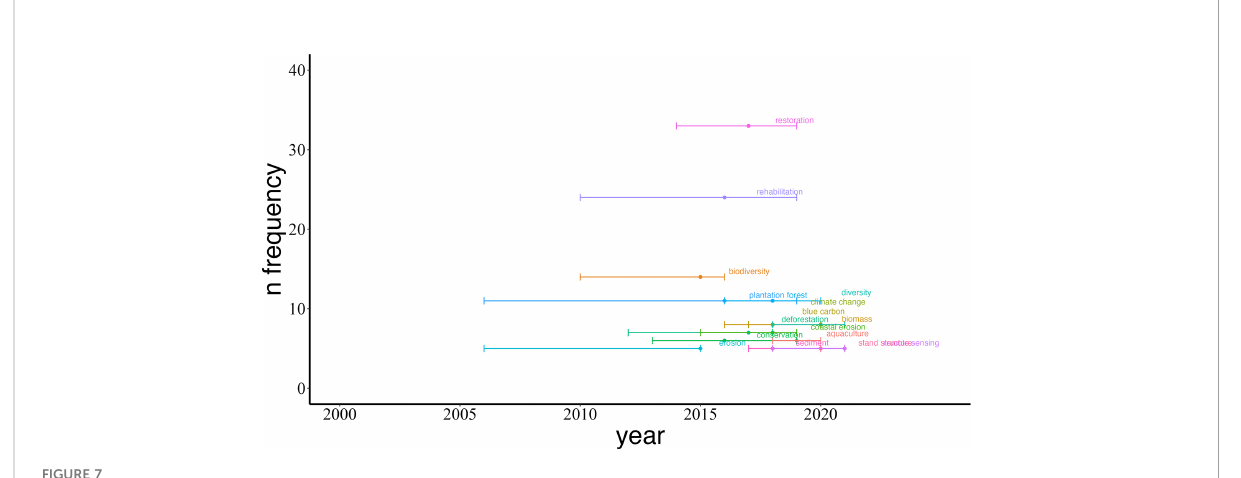
FIGURE 7 Topic trends using author ’ s keywords over the